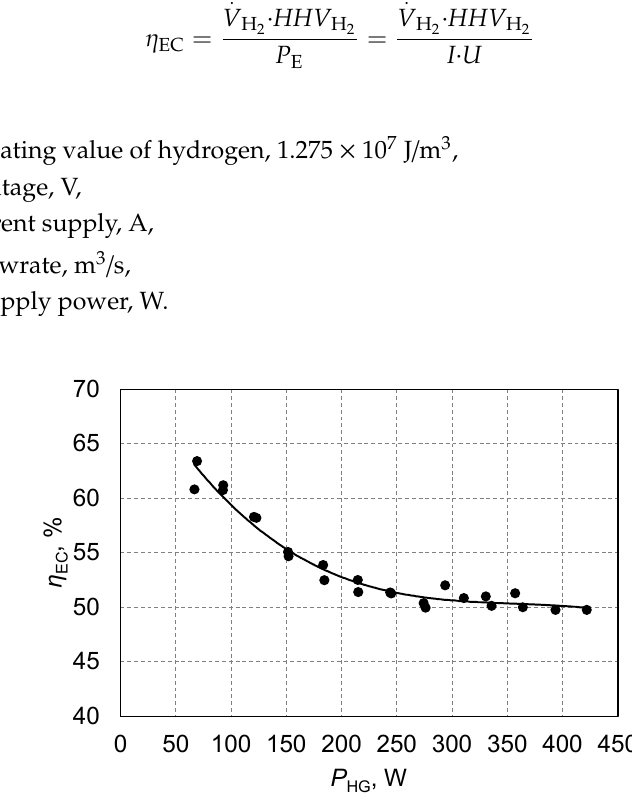
Figure 2. Scheme of the electrolyzers supplied with electricity from photovoltaic (PV) panels.